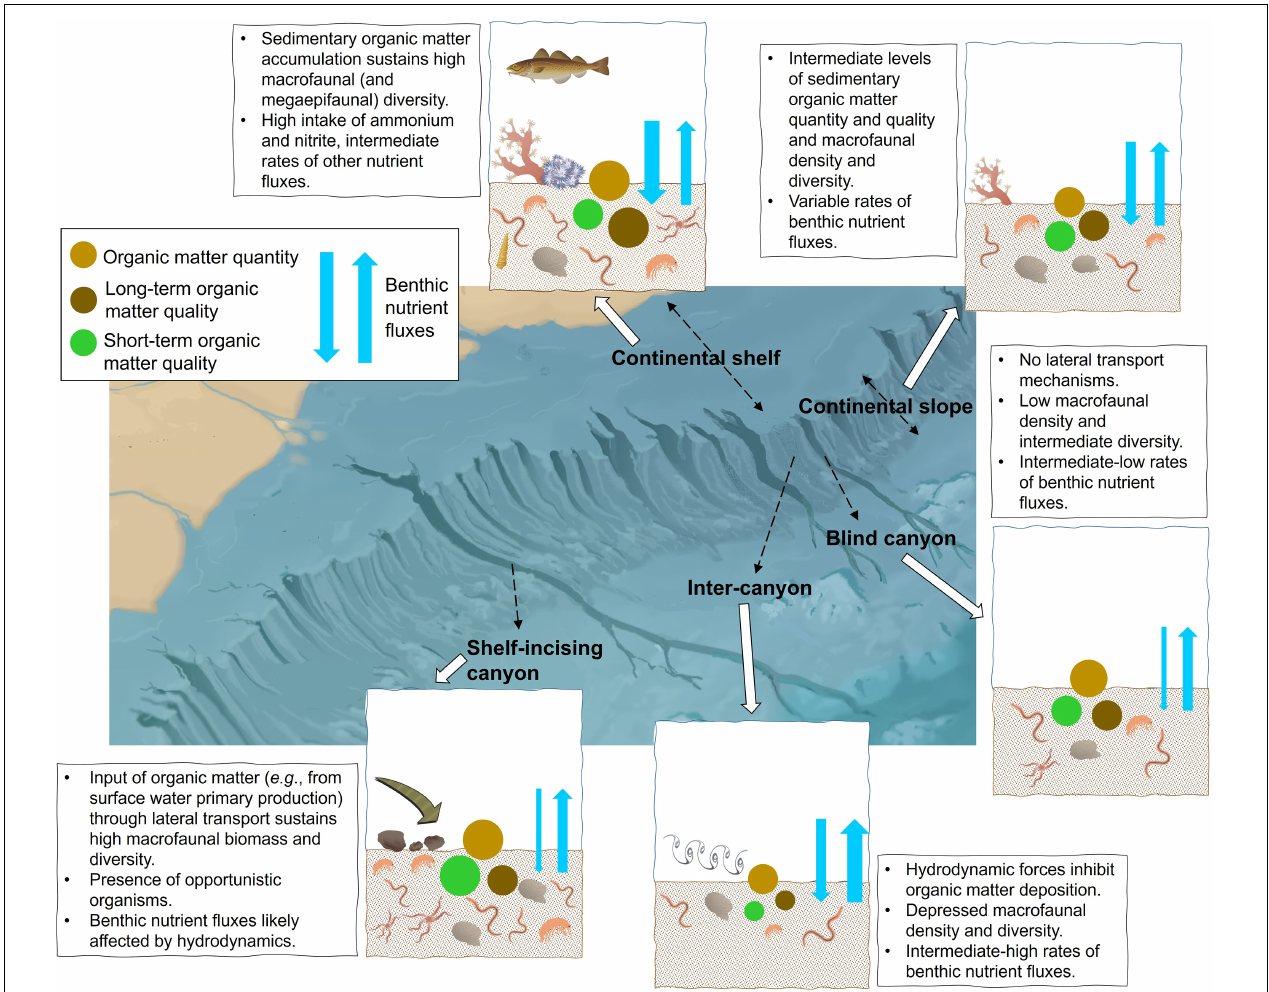
FIGURE 7 | Schematic summary of the main characteristics of different habitats along continental margins, based on our findings from the stations sampled in this study. Dimensions of dots and arrows are proportional to the amount of sedimentary organic matter (quantity, short-term, and long-term quality) and benthic nutrient flux rates (influxes and effluxes), respectively. Diagram of the continental margin was modified from Encyclopedia Britannica Inc. ; organisms’ icons were provided by Integration and Application Network